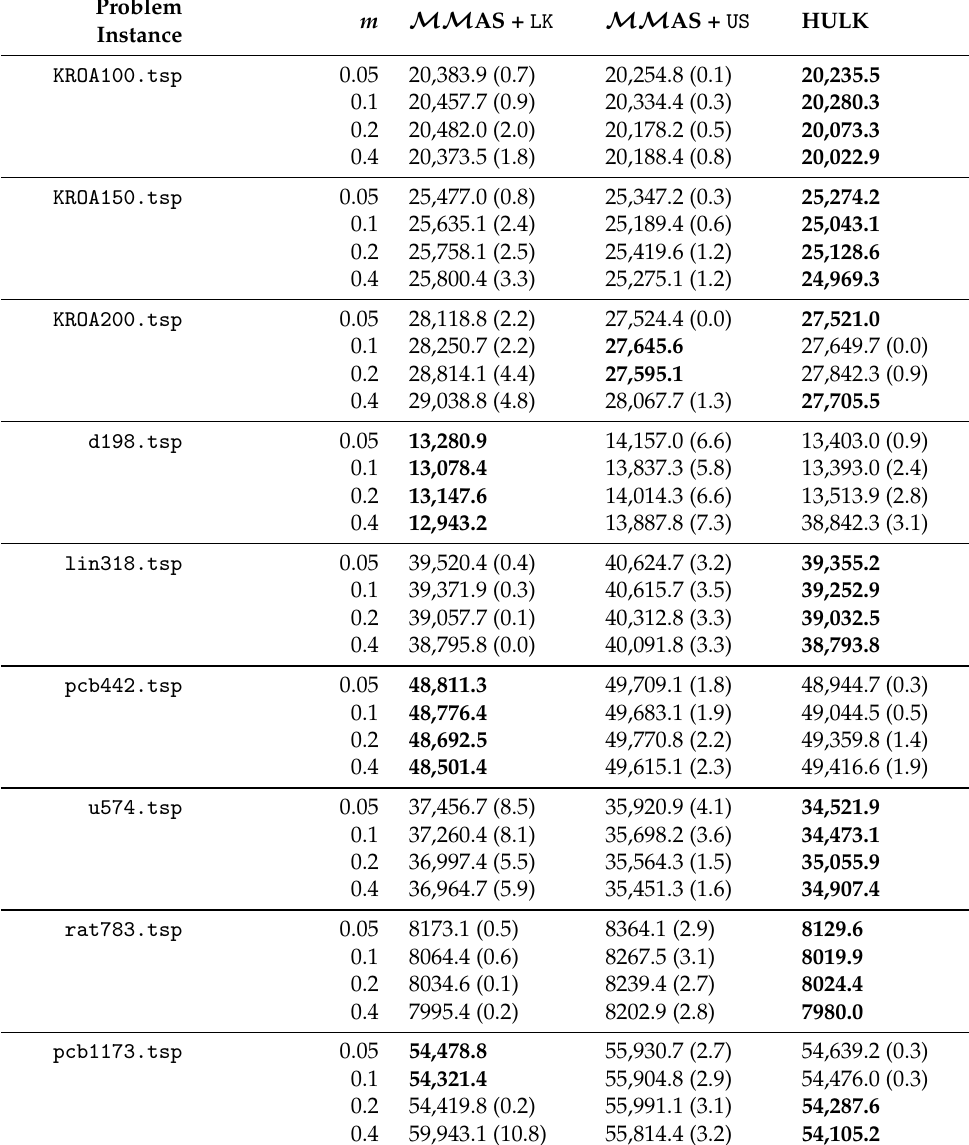
Table 3. Experimental results regarding the average offline performance of the presented methods on symmetric DTSPs. The number between brackets means the distance in percentage from the current value to the best value, in